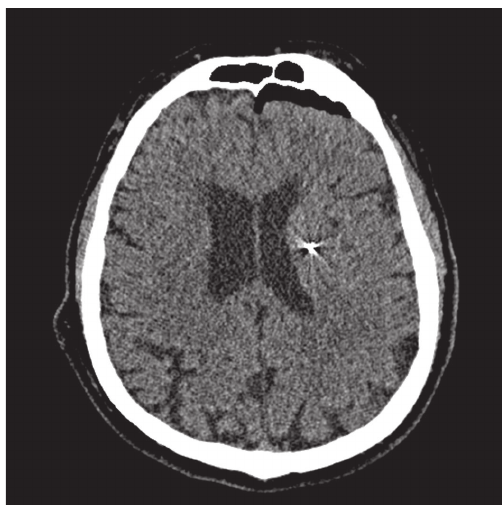
hemorrhage along DBS tract immediately aer DBS placement.